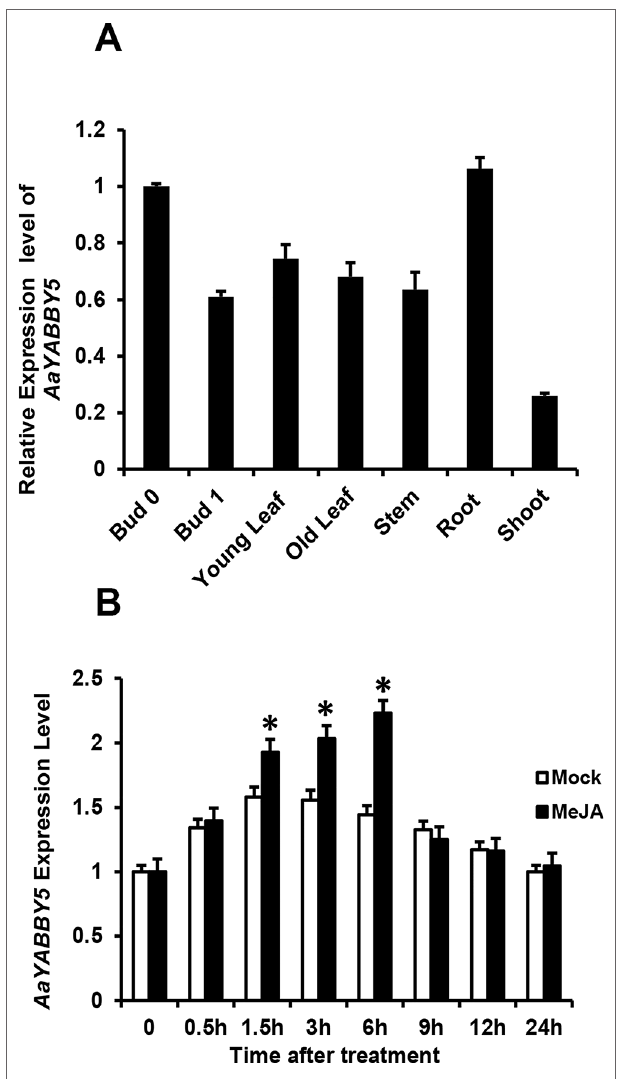
FIGURE 6 | Expression and induction pattern of AaYABBY5 . (A) Relative expression of AaYABBY5 was analyzed from different tissues of 5-month-old Artemisia annua plants. β -Actin was used as an internal standard. Values represent the mean ± SD of three replicates. Error bars represent the standard deviation for n = 3. (B) AaYABBY5 expression, in response to 100-µM MeJA, was analyzed in 4-week-old A. annua leaves. Water with 1% DMSO solution was used as mock solution. β -Actin was used as an internal standard. Values represent the mean ± SD of three experimental replicates. Error bars represent standard deviation for n = 3. Statistical significance was determined by Student’s t -test with paired and two-tailed distribution methods. Asterisks indicate the difference between treated and nontreated plants. * P < 0.05.